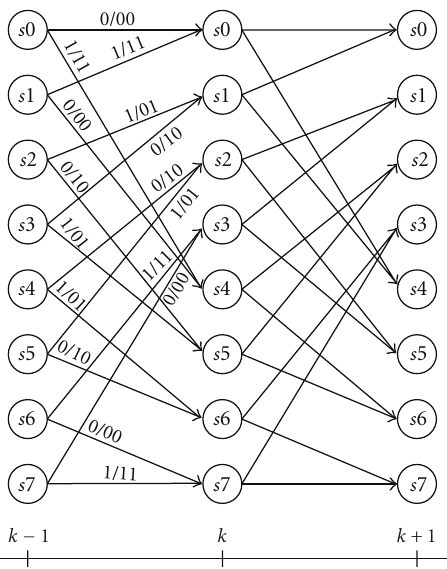
Figure 2: Example of an 8-state trellis diagram.